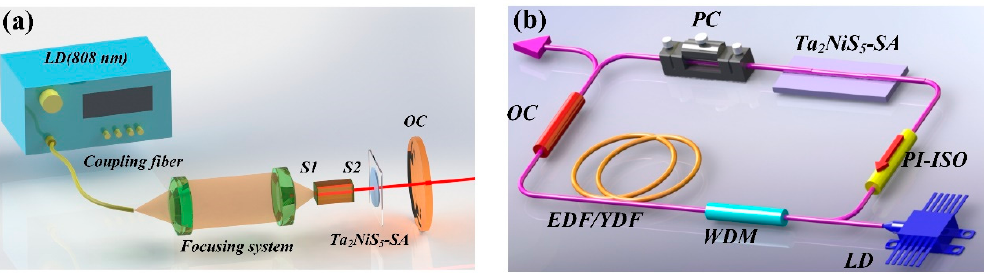
Figure 4. ( a ) Schematic setup of the diode-pumped Ta 2 NiS 5 -SA-based PQS Nd: YAG laser. ( b ) Cavity schematic for the ML fiber